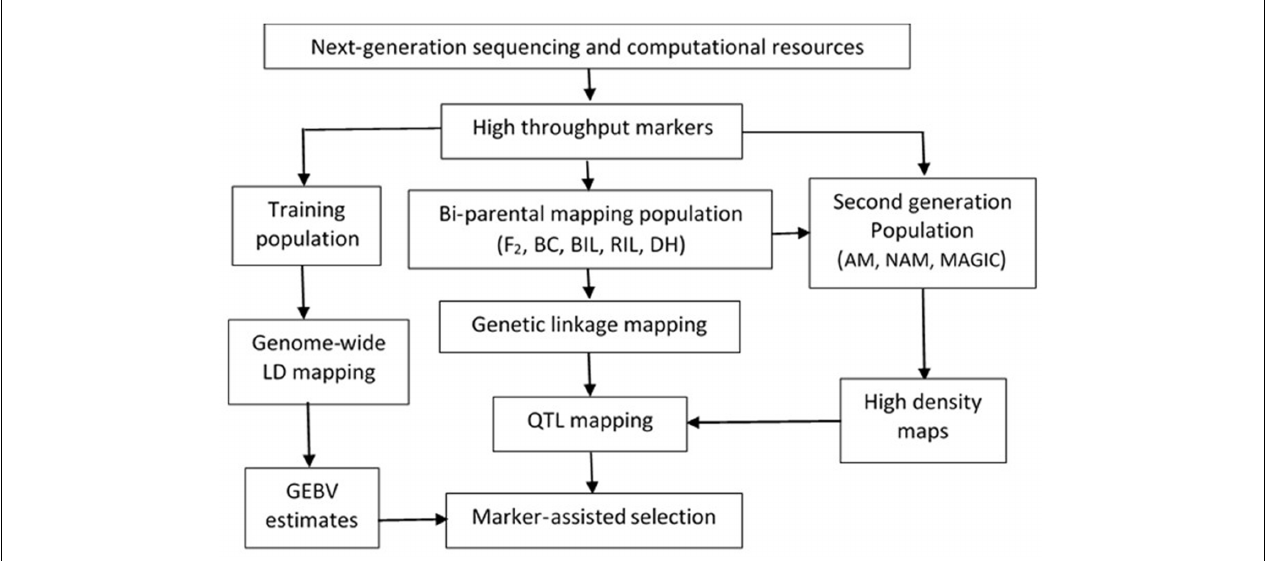
FIGURE 1 | Conceptual flow of molecular breeding using advanced genomic tools that can be applicable to pearl millet (F2, second filial generation; BC, backcross population; BILs, backcross inbred lines; RILs, recombinant inbred lines; DH, doubled haploid; AM, association mapping population; NAM, nested association mapping population; MAGIC, multi-parent advanced generation intercrossing population; GEBV, genetic and breeding value).